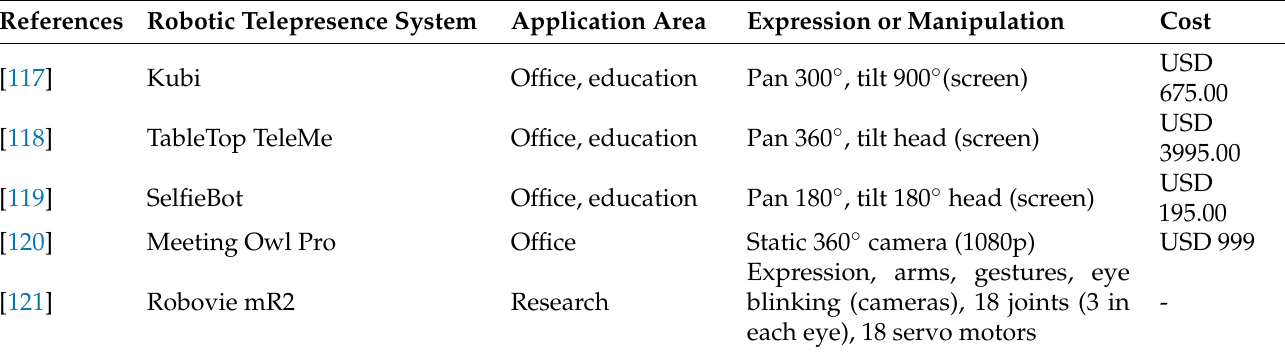
Table 6. Unmovable robotic telepresence (RP)